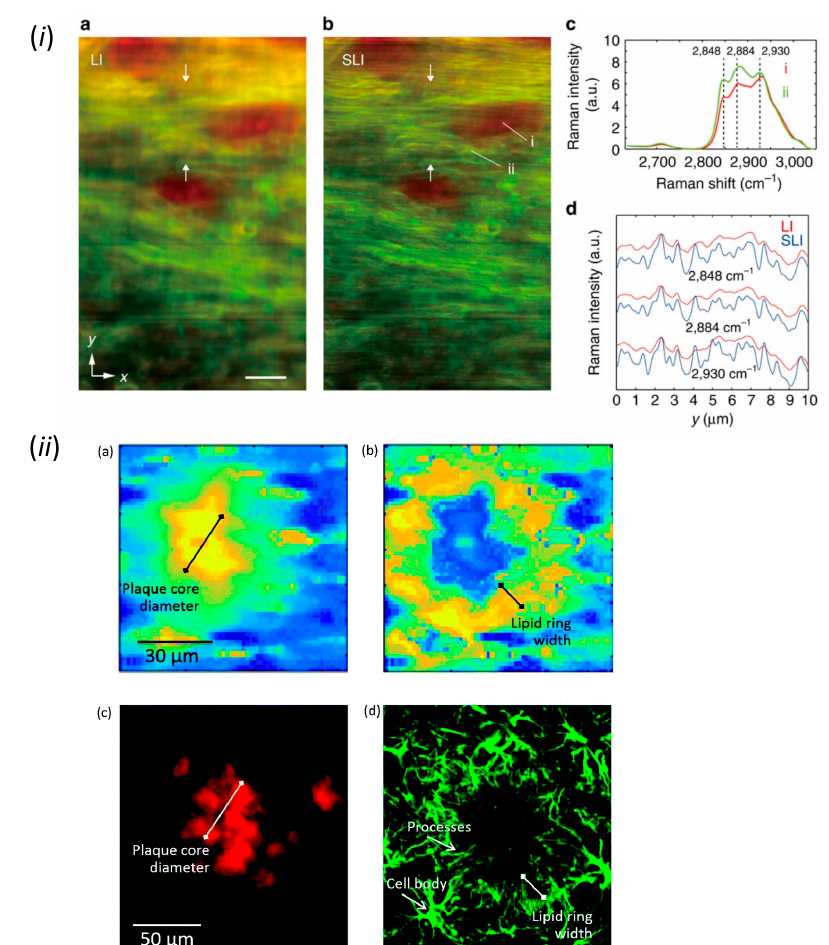
Figure 3. Imaging of biomolecules by Raman microscopy. ( i ) Raman spectrum imaging of beta sheets (red) and lipids (green) in the corpus callosum of fixed brain slice. (Scale bar, 20 µm). Adapted from Figure 4 Watanabe et al., 2015 [77]. ( ii ) Raman spectrum imaging of beta sheets in amyloid plaque and lipids in surrounding reactive astrocytes. Adapted with permission from Figure 4 in Palombo et al., 2018 [78].